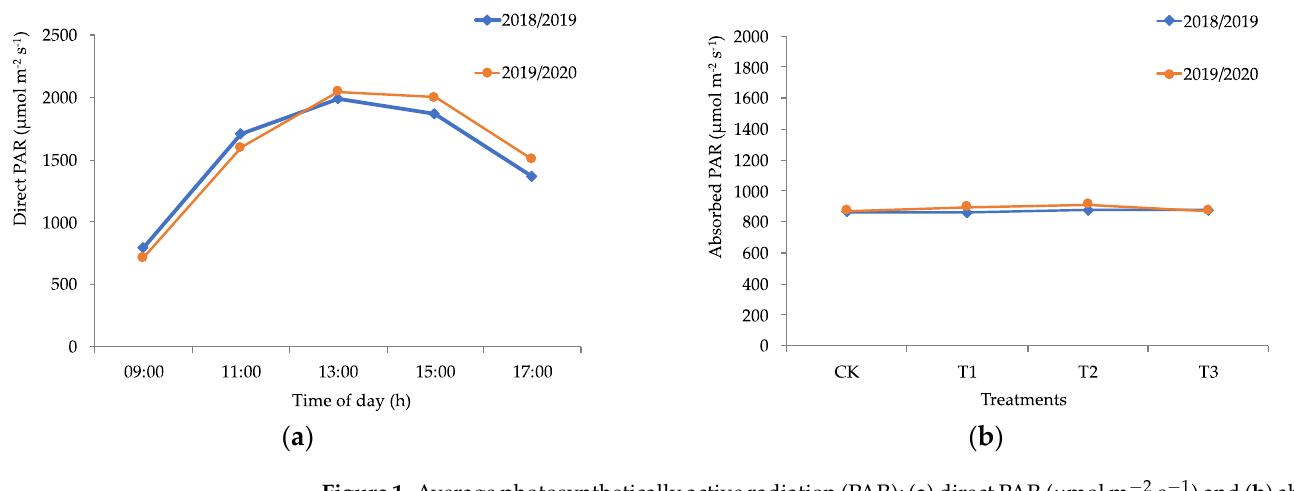
Figure 1. Average photosynthetically active radiation (PAR); ( a ) direct PAR ( μ mol m − 2 s − 1 ) and ( b ) absorbed PAR ( μ mol m − 2 s − 1 ) for the different treatments for the seasons 2018–2019 and 2019–2020. For Figure 1b: according to Fischer’s LSD test ( p < 0.05), there are no significant differences between treatments; the experimental error was very small, so the error bars were not observed.